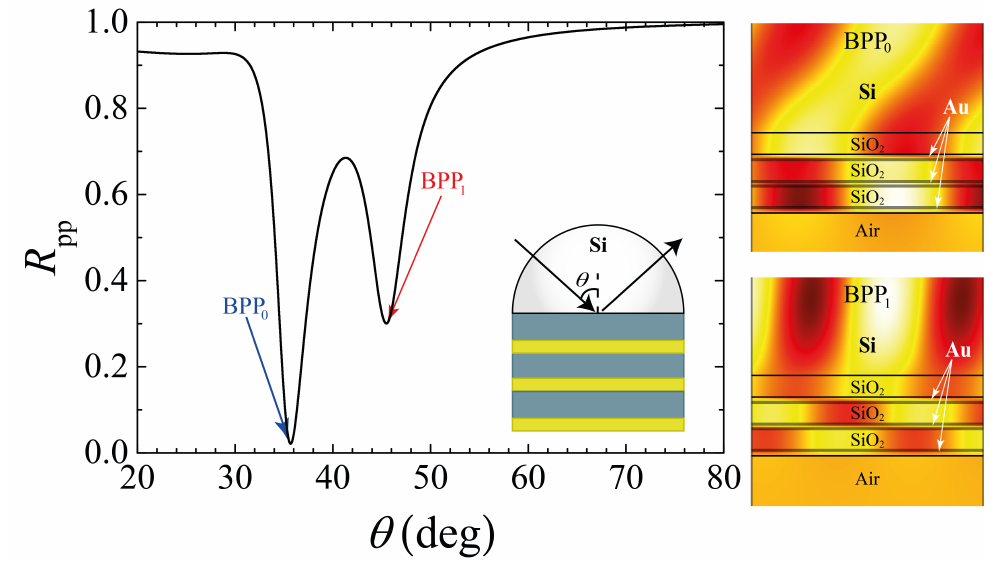
Figure 2. Numerical reflectance as a function of the angle of incidence. The reflectance dips labeled with BPP 0 (35.68 ◦ ) and BPP 1 (45.48 ◦ ) indicate the two BPP modes that are excited in the multilayer structure. The corresponding magnetic field profiles are shown in the top and bottom right side panels. The finite multilayer structure, consisting of a Si-prism and a tri-bilayer system, is depicted in the